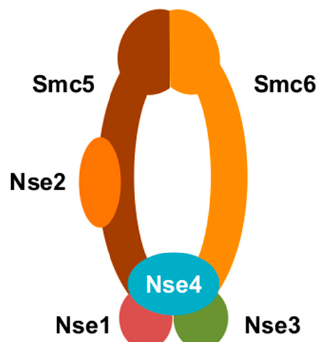
Figure 1. A cartoon representation of structural maintenance of chromosome 5/6 complex (Smc5/6). Smc5/6 is composed of Smc5, Smc6, Nse1, Nse2, Nse3, and Nse4.